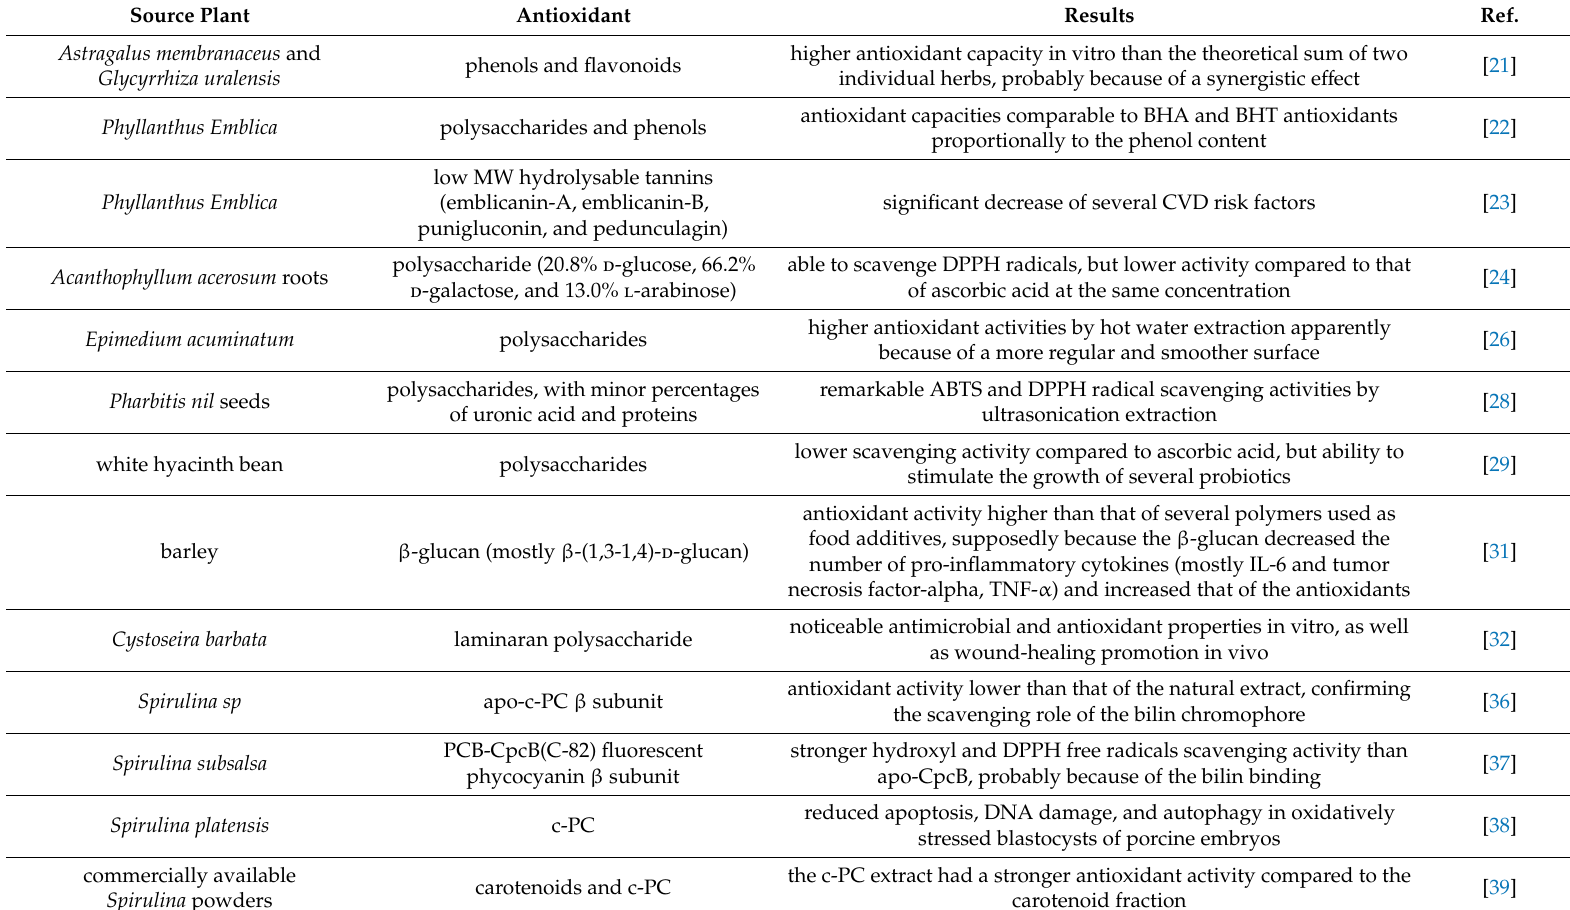
Table 1. Summary of the antioxidant polymers deriving from natural sources and their e ff ects. ABTS: 2,2 (cid:48) -azino-bis(3-ethylbenzothiazoline-6-sulfonic acid), DPPH: 2,2-diphenyl-1-picrylhydrazyl, MW: molecular